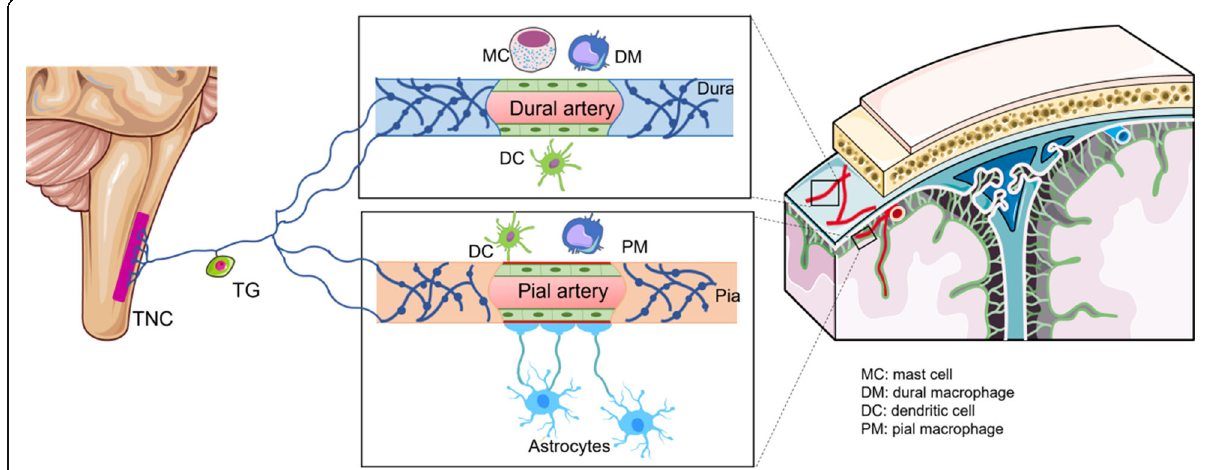
Fig. 2 CSD activates trigeminal nociceptors around pial and dural vessels as well as meningeal macrophages and dendritic cells within 6 – 20 min in rodents [17]. Mast cell degranulation also contributes to the sterile meningeal inflammatory response. These inflammatory cells are in close proximity to the meningeal nociceptor fibers (pial nociceptive fibers and their axon collaterals around dural vessels) and may contribute to sustained stimulation and sensitization of nociceptors after initial activation, causing hours to days lasting headache. Blood-brain barrier (BBB) impermeable drugs such as anti-CGRP antibodies and sumatriptan can reach dural nociceptors located outside the BBB unlike pial nociceptors under the pial membrane. This figure is produced using Servier Medical Art